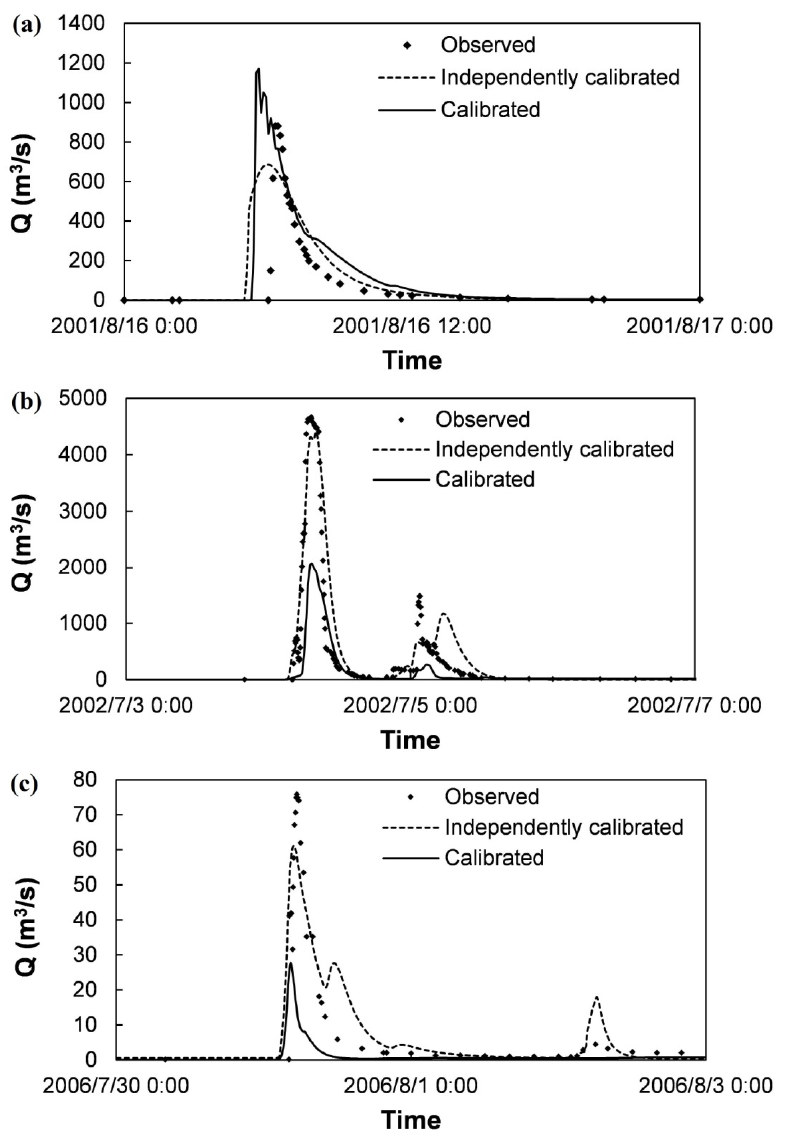
Figure 5. Calibrated runoff processes compared with observations of the three events in the upstream of the Qingjian River basin: ( a ) 2001, ( b ) 2002 and ( c ) 2006.